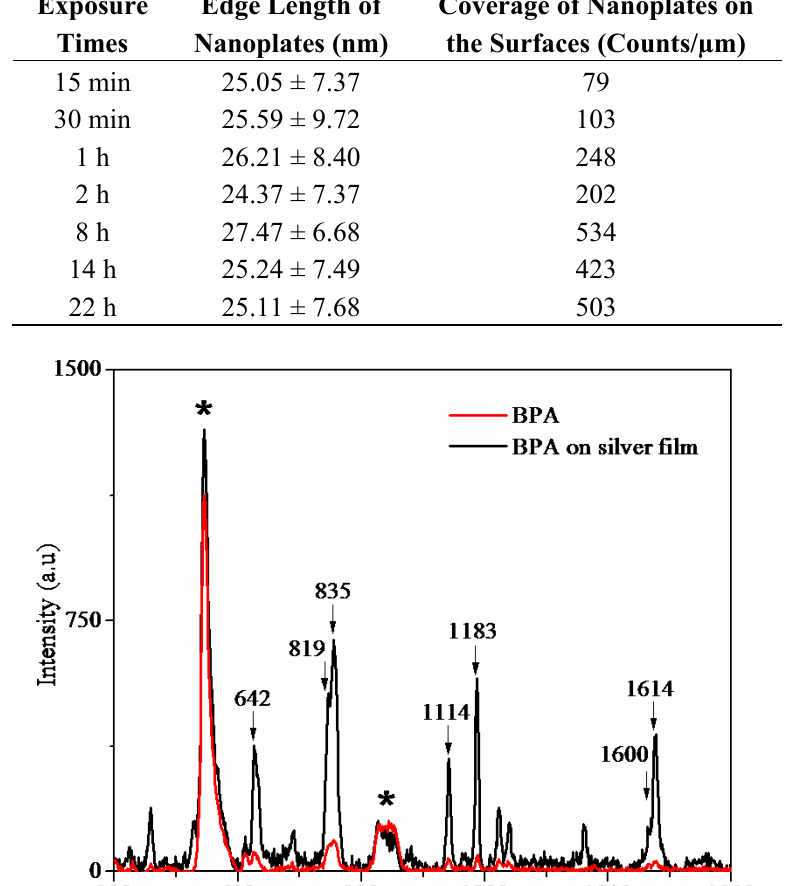
Table 1. The measurement of the edge length and the coverage of triangular nanoplates on the surface for 15 min to 22 h samples of exposure times.